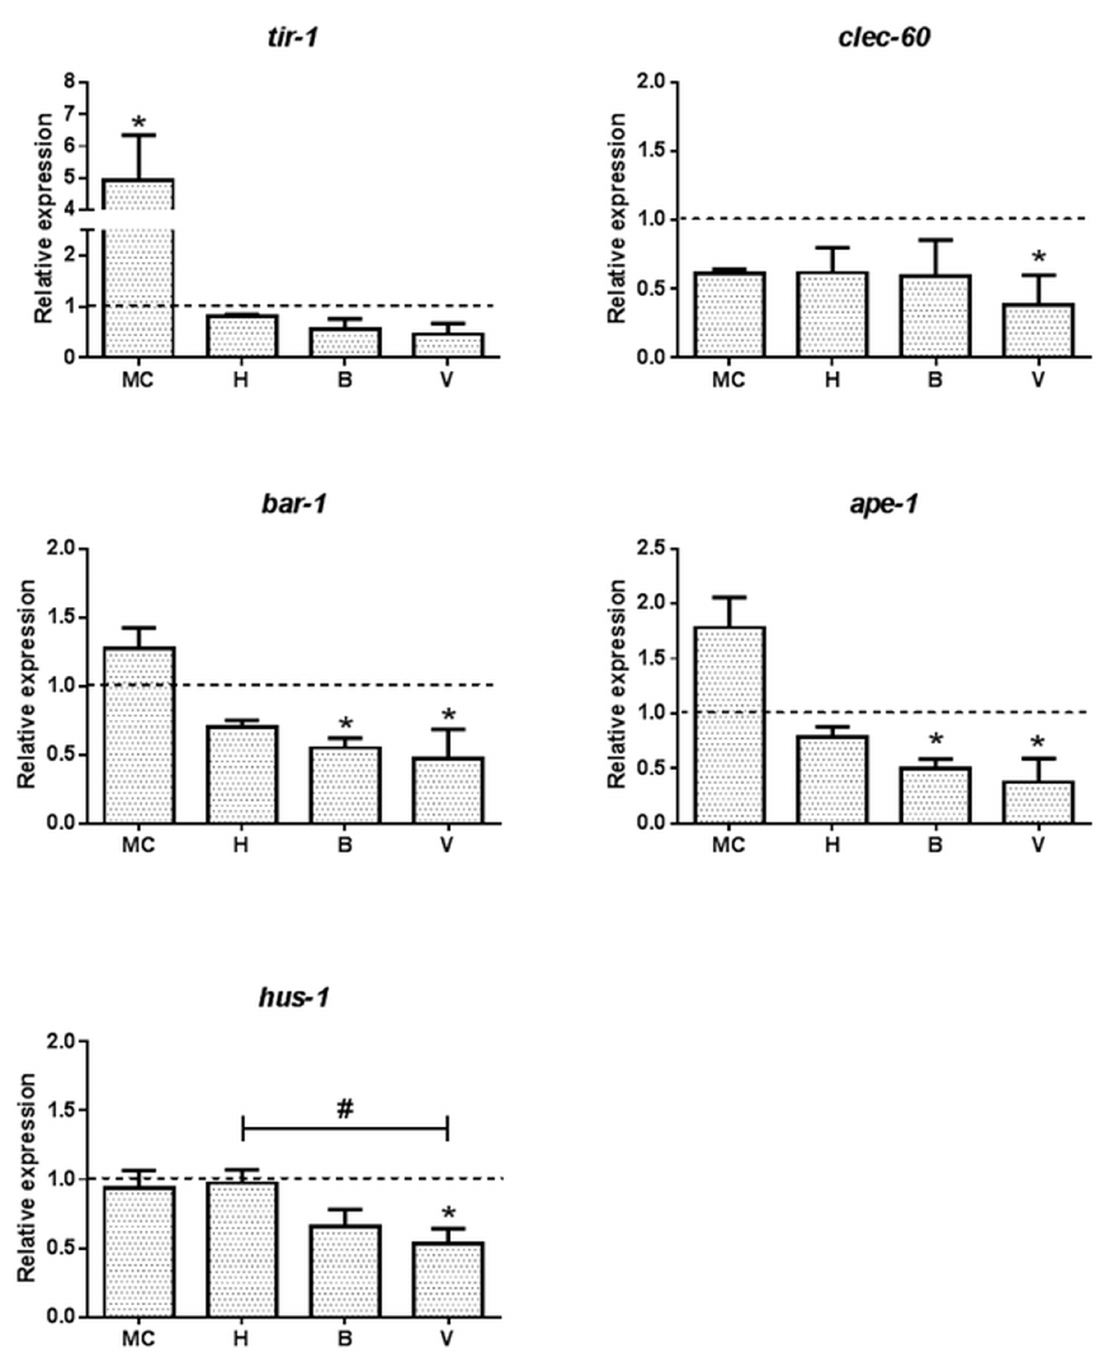
Fig 6. Effect of metal exposure on C . elegans genes involved in apoptosis and innate immunity. Apoptosis marker genes ape-1 and hus-1 and innate immunity modulators tir-1 , clec-60 , and bar-1 were analysed in C . elegans treated with the metal cocktail (MC) or waters from Lake Hornträsket (H) and Vombäcken stream at Björn å s (B) and the exit to Vindelälven (V). One way analysis of variance (ANOVA) followed by Tukey ’ s post-test was used for multiple group comparison where * refers to p < 0.01 as compared to control and # represents significant differences in between the sites H, B and V. The dotted line represents the expression level normalized to that of the control (K-medium prepared with Milli-Q water).